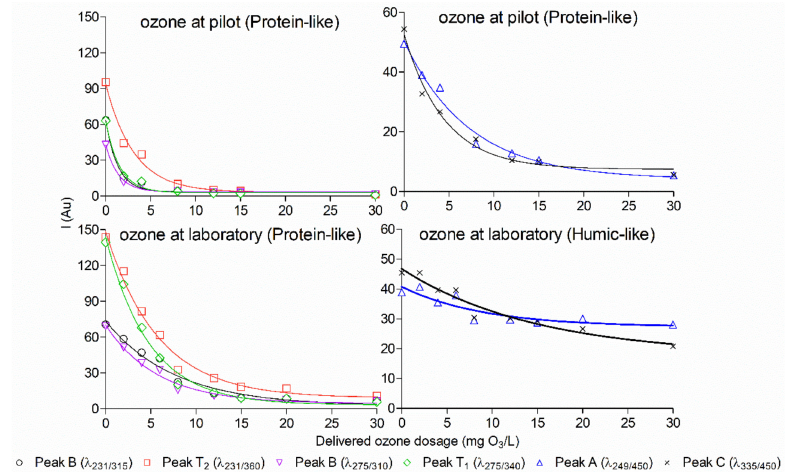
Figure 3. Comparison of the remaining natural fluorescence of the pilot-scale staged MBBRs e ffl uent treated with ozone, using the pilot or the laboratory